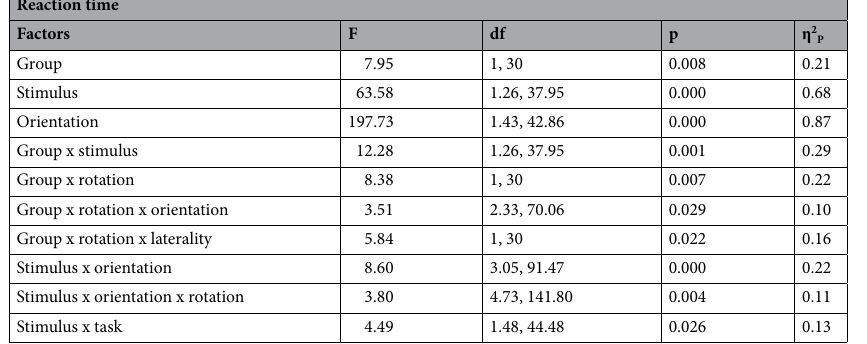
Table 2. Significant results of the ANOVAs on the RT data with stimulus type (hand vs. house vs. letter), laterality (ipsilateral vs. contralateral), rotation (medial vs. lateral), orientation (0° vs. 45° vs. 90° vs. 135° vs. 180°) and task (laterality judgment vs. matching) as within-participant factors and group (CRPS vs. control) as between-participant factor. df degrees of freedom.